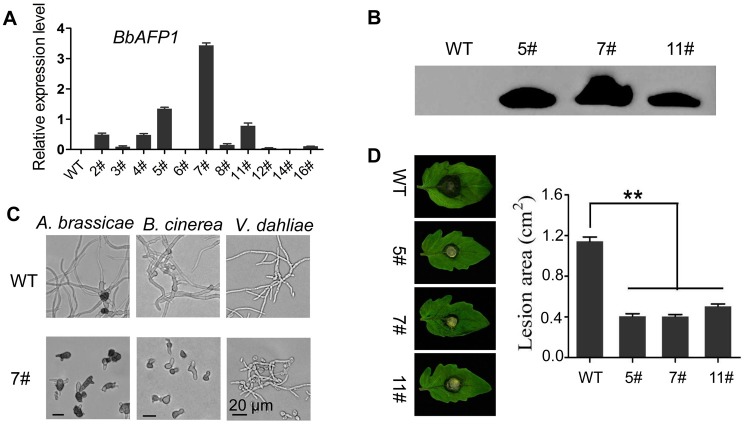
Transgenic expression of BbAFP1 in tomato (S. lycopersicum) and effect on resistance to fungal pathogens.(A) Expression of BbAFP1 in independent transgenic tomato lines as examined by qRT-PCR with tomato tublin as the reference gene. (B) Western blot analysis of BbAFP1 protein production in transgenic tomato lines. Anti-BbAFP1 antibody was used as primary antibody. (C) Inhibition of A. brassicae (representative image 12 h post-treatment), B. cinerea (15 h post-treatment), and V. dahliae (24 h post-treatment) by leaf extracts of BbAFP1-expressing transgenic tomato. (D) Detached leaf bioassays of disease progression in plants inoculated with B. cinerea. Lesion area caused by B. cinerea was measured. Representative images were taken 3 d post inoculation, respectively. WT, wild-type tomato; 5#/7#/11#, transgenic tomato lines. Error bars = SD, ** indicates P < 0.01, t-test.